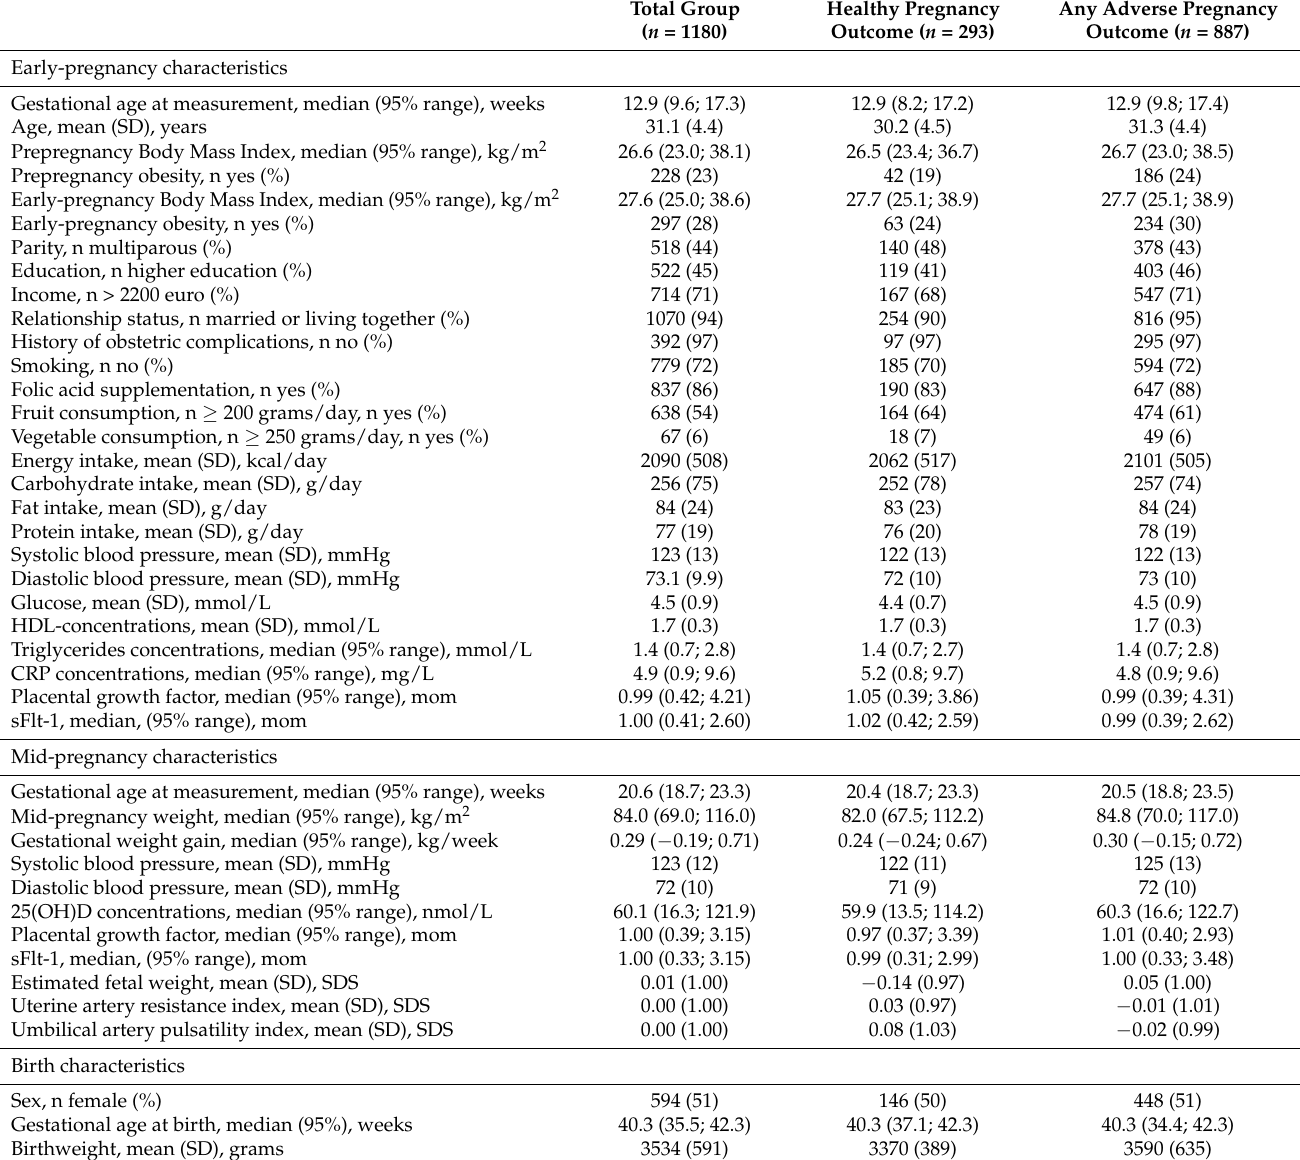
Table 1. Population